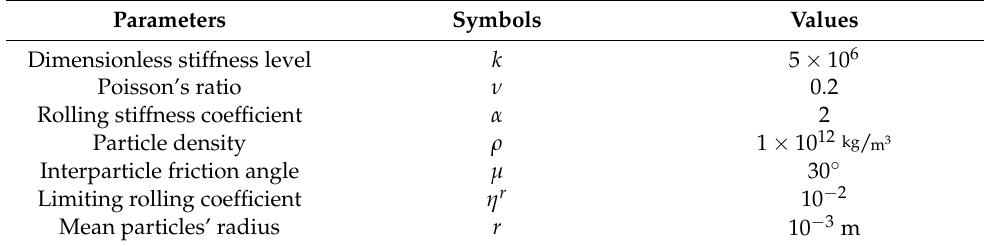
Table 1. Input parameters selected for the numerical